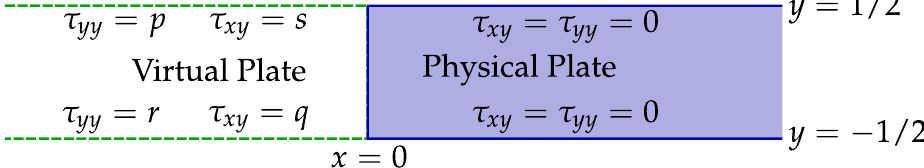
Figure 3. The construction we use to implement corner modes. The shaded physical plate has traction free conditions on top and bottom, but the condition on the face x = 0 will be applied later. The dashed lines denote an extended ‘virtual’ plate where we are imposing tractions on the surfaces which capture the correct local form of the stresses in the